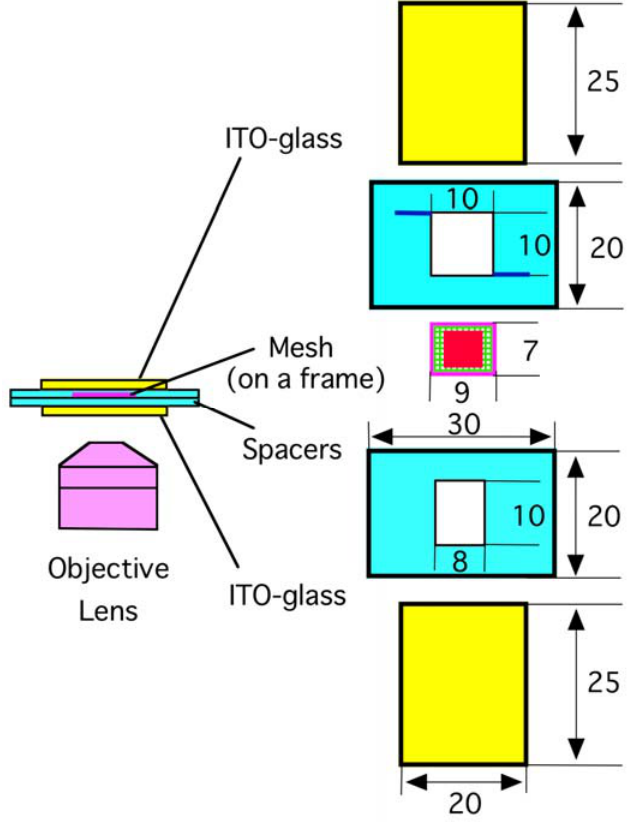
Figure 1. An electroformation chamber with a mesh substrate. A small piece of a polymer mesh with a deposit of egg yolk phosphatidylcholine (shown as a red square) was placed at the median between the two electrodes. Two thin channels were carved on the upper spacer (shown as two blue lines) for the introduction of ultrapure water into the chamber. The unit of length is millimeter. ITO: Indium tin oxide coated